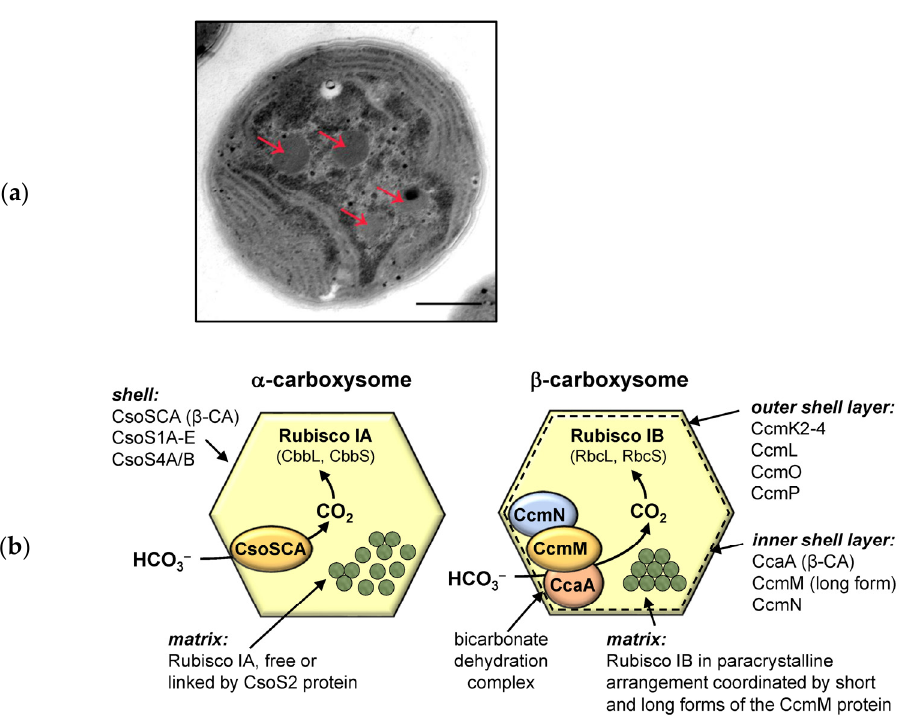
Figure 5. Cyanobacterial carboxysomes. ( a ) Carboxysomes (arrows) in the cytoplasm of the cyano- bacterium Synechocystis sp. strain PCC 6803. Image was kindly provided by Dr. M.A. Sinetova (K.A. Timiryazev Institute of Plant Physiology, RAS, Moscow). Scale bar is 0.5 µm. ( b ) Structural compo- nents of α - and β -carboxysomes in Prochlorococcus marinus MED4 ( α -cyanobacteria) and Synechococcus elongatus PCC 7942 ( β -cyanobacteria). Modified from [174]; supplemented from [89,175]. The proteins of the inner layer of the β -carboxysome shell form a bicarbonate-dehydrating complex that converts HCO 3 − to CO 2 for the RPP cycle [184]. The organizing link of the complex is a full-length form of the CcmM protein, which simultaneously binds Rubisco, CcmN and CcaA ( β -CA). The complex is associated with the carboxysome shell through specific interactions of CcmM with proteins in outer shell layer, CcmK and CcmL. Bicarbonate dehydration is performed by the CcaA or CcmM CAs. Another component of cyanobacterial carboxysomes is Rubisco